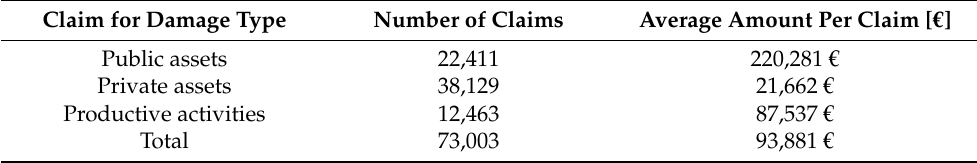
Table 3. Summary of claims in the available dataset.